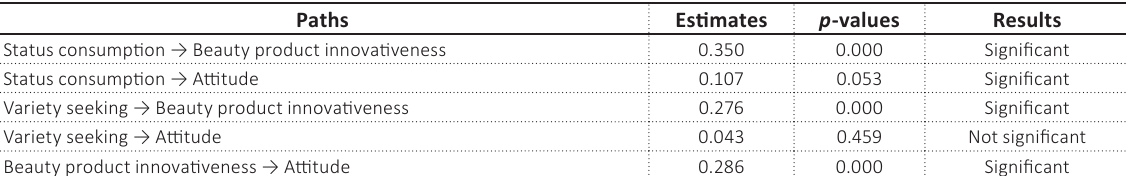
Table 7. Standardized regression estimates and p -values